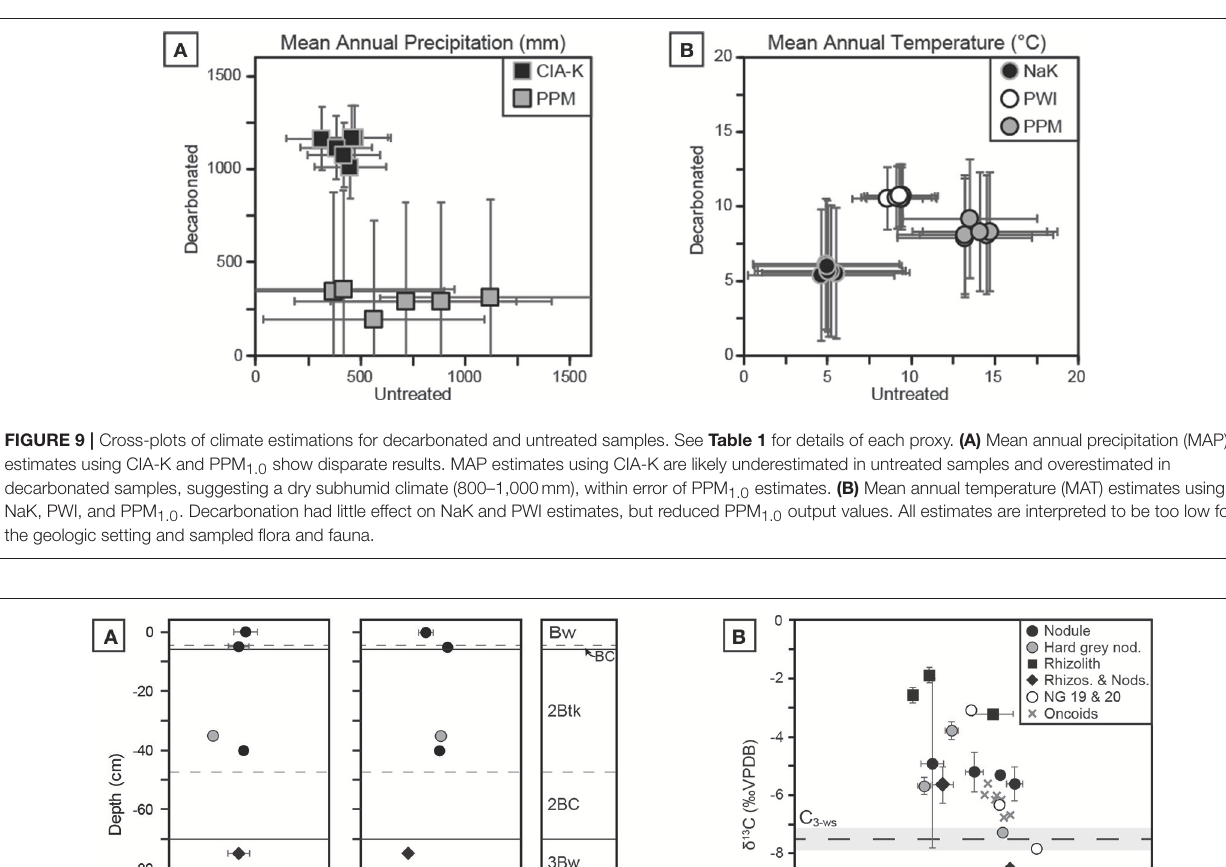
Figure 10 ; raw values are reported in Table A4. Values for δ 13 C span approximately 9‰, ranging from − 7.3 ± 0.1 to